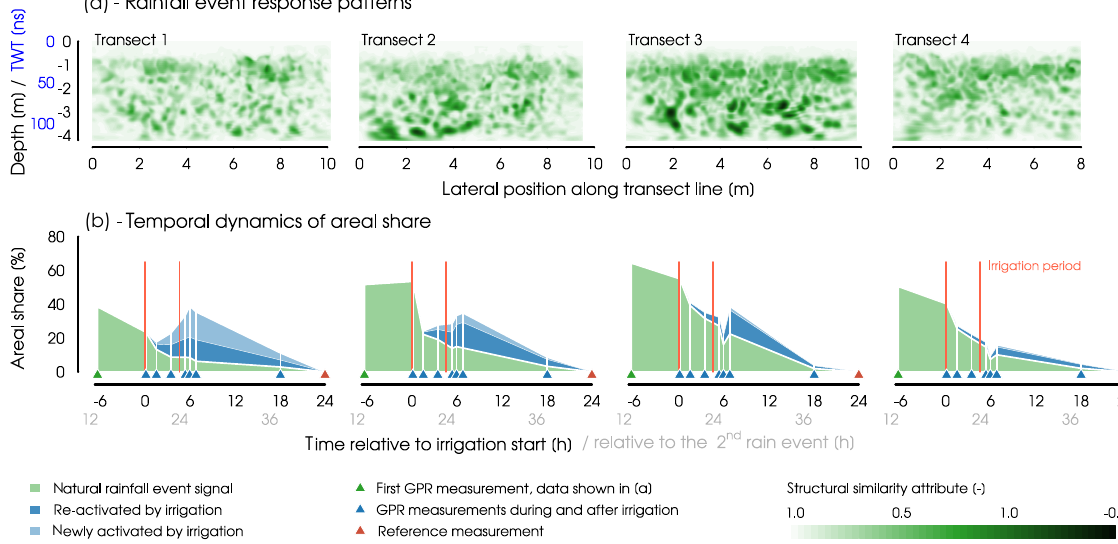
Figure 6. (a) Two-dimensional GPR data showing the subsurface response patterns caused by the natural rainfall event. The data show the structural similarity between the first GPR measurement (approximately 6:30h before irrigation start and 12:52h after the second rainfall event) and the last one. Low values of structural similarity are interpreted as high changes in soil moisture. (b) Temporal dynamics of the areal share of active regions attributed to the natural rain event and the irrigation. Activated regions were identified by a structural similarity attribute of less than 0.85. Data were interpolated linearly between the measurements for visualization. The measurements shown in (a) show the data used to calculate the first data point shown in (b) .